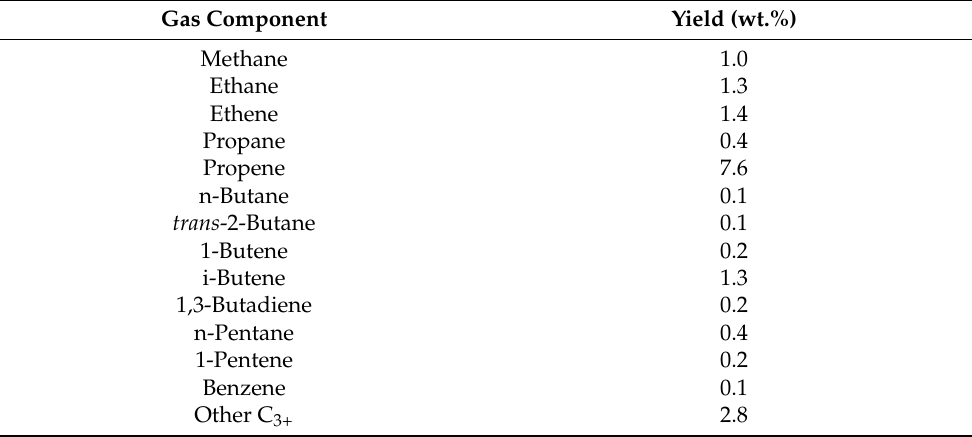
Table 2. Yield of individual gas components (wt.% of feedstock) during pyrolysis of polypropylene.